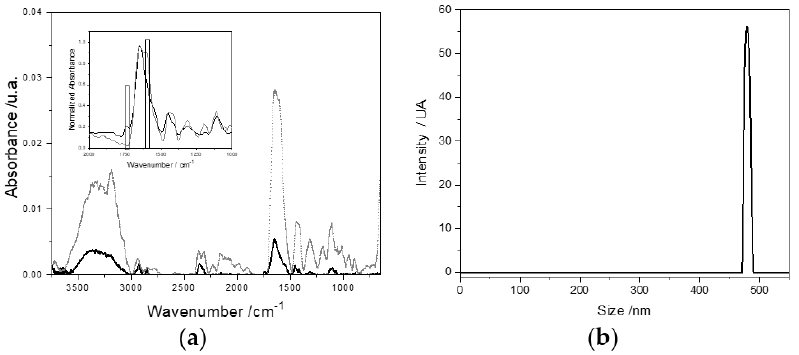
Figure 1. ( a ) FTIR of the hydrogel PAAm (black) and the NanoC (PAAm-GO, gray); and ( b ) Dynamic Light Scattering (DLS) of a graphene oxide